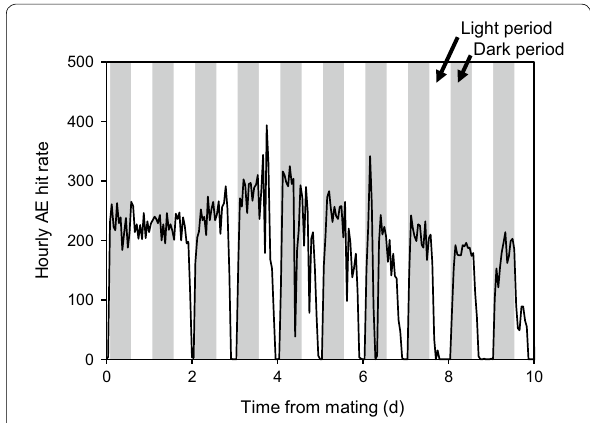
Fig. 12 Time course of the hourly AE hit rate of a male (individual M1). Light and dark periods indicated on the background in white and gray ,